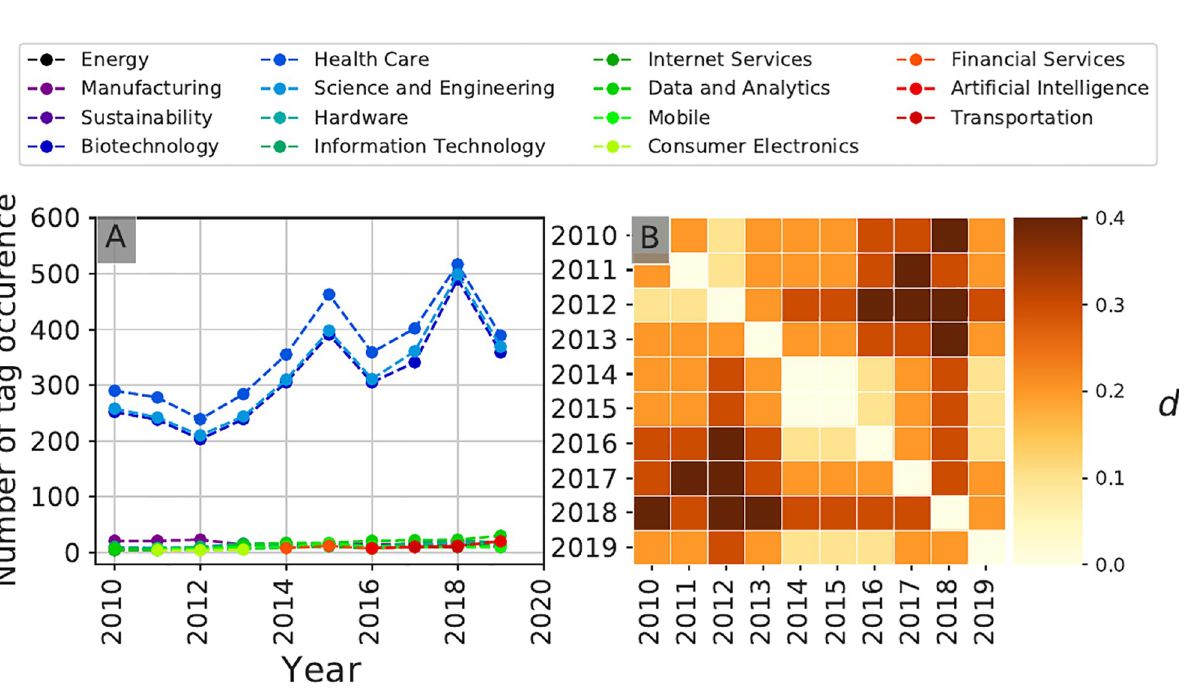
Fig 10. Temporal evolution of the investment patterns of community A7. Temporal community investment patterns of the target startups’ sectoral tags for each year aggregated at the community level. Community A7 is comprised of Health Care-specialized venture capitalists. Panel A shows for each year the ten tags that received the most investments, panel B shows the community self-difference index described in Eq 4, with two markedly different areas of coherence, before and after